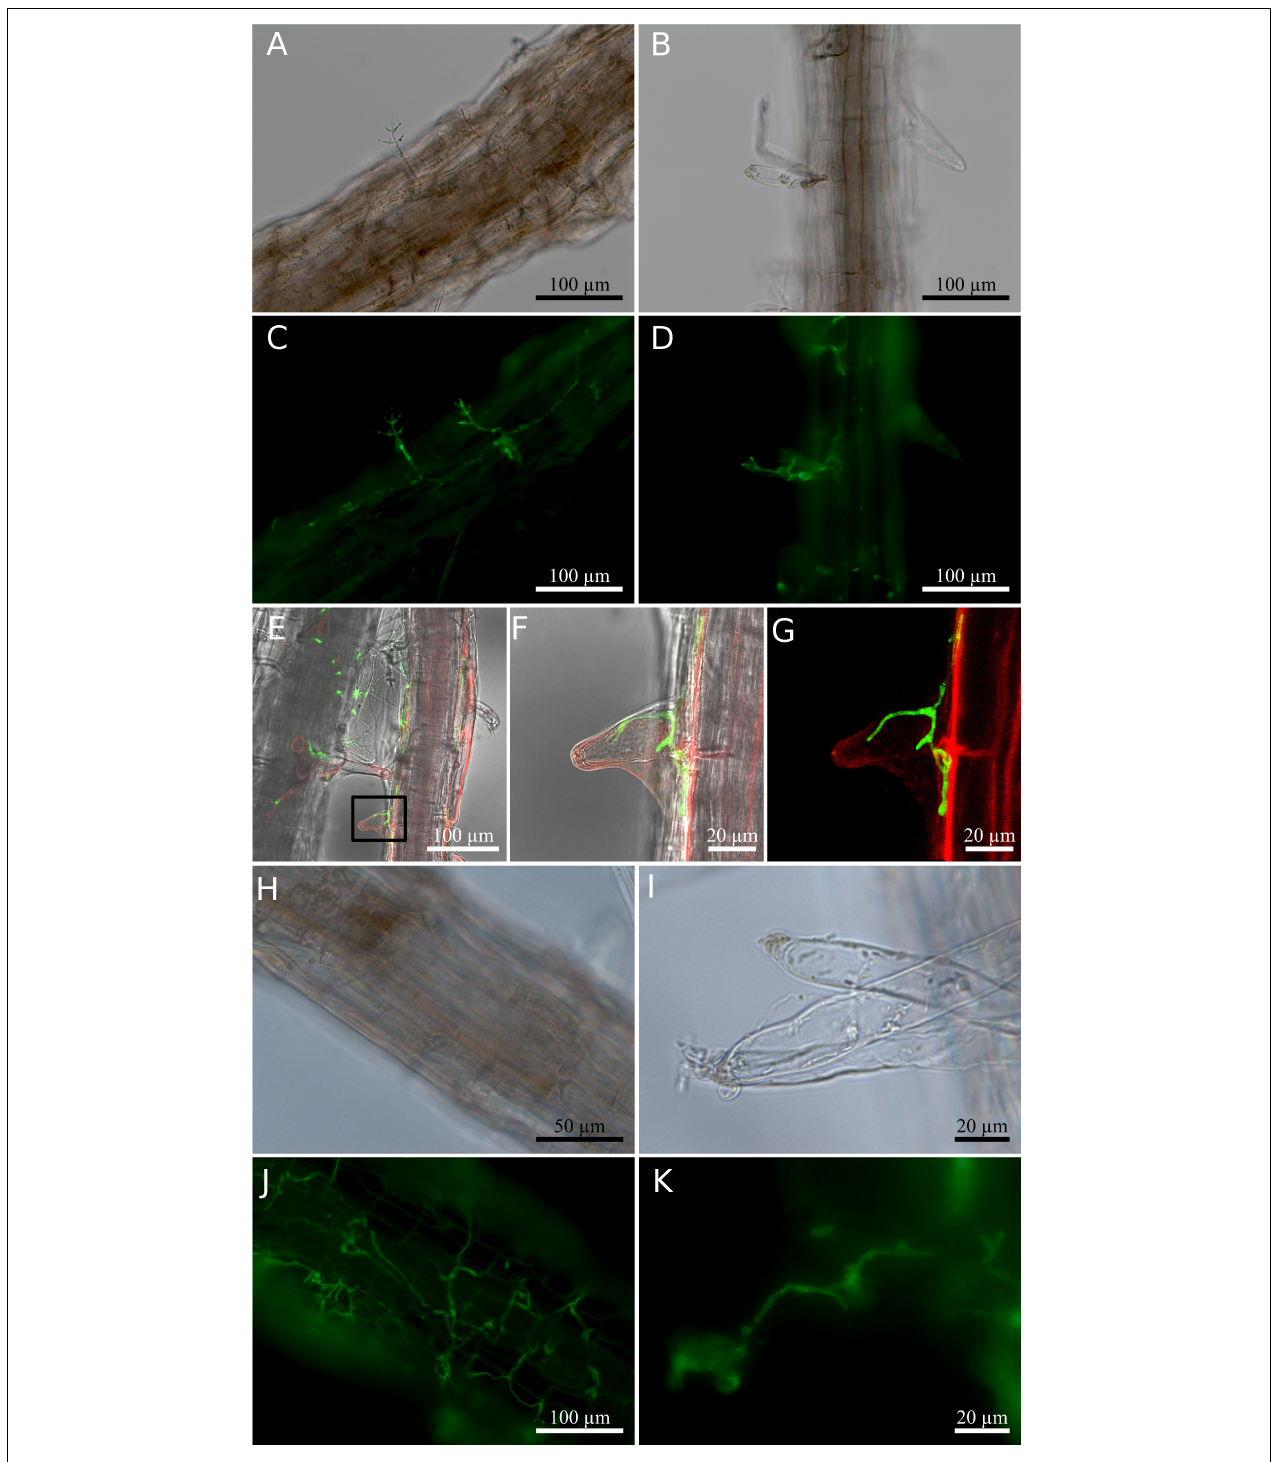
FIGURE 2 | Root colonization of Arabidopsis thaliana by Trichoderma . (A–D) Co-cultivation for 2 days. (A,B) Bright field; (C,D) fluorescence of fungal stain. (E) Confocal images of hyphae inside root hair observed 2 days after co-cultivation. (F) Magnified view of the region enclosed by the small box in (E) . (G) Fluorescence signal indicating hyphae (green) and plant cell plasma membrane (red) in (F) . (H–K) Co-cultivation for 7 days. (H,I) Bright field; (J,K) fluorescence of fungal stain. Colonized root tissues were stained with WGA Alexa FluorTM 488 conjugate to detect the presence of the fungus, and RH414 was used to visualize the plant plasma membrane. The image shown for the confocal microscopy was chosen from three individual roots of three biological replicates.